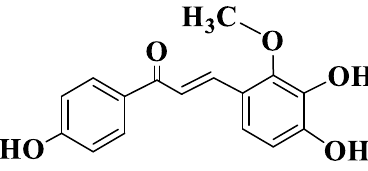
Figure 2. Structure of Licochalcone B.